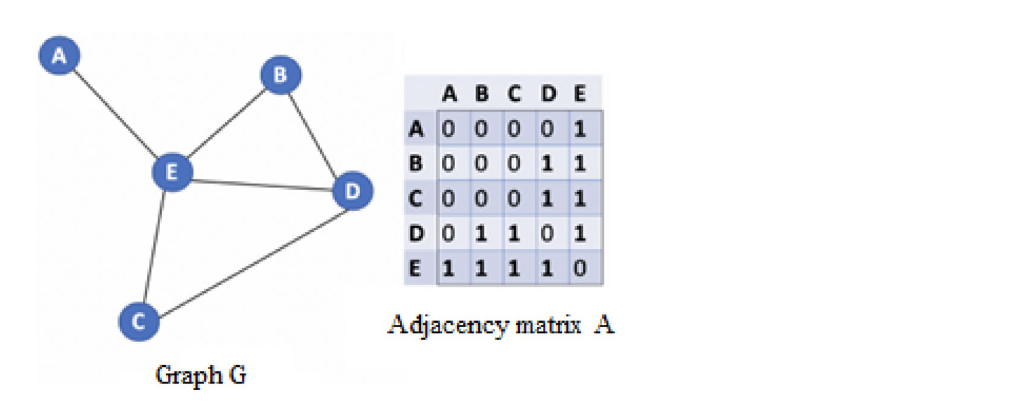
Figure 4. The labels of Brodmann areas (using Paint 3D version 6.1907.29027.0 https:// apps. micro soft. com/ store/ detail/ paint- 3d/ 9NBLG GH5FV 99? hl= en- us& gl= US).